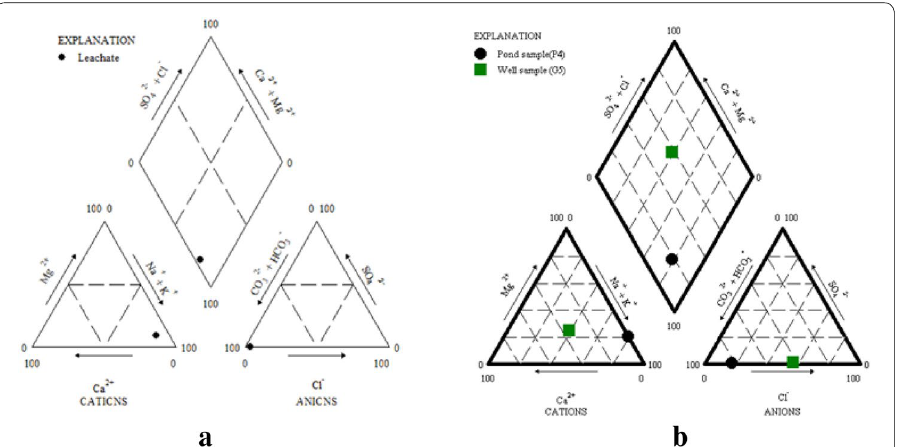
Fig. 5 Piper diagram, composition of a leachate samples; b water bodies